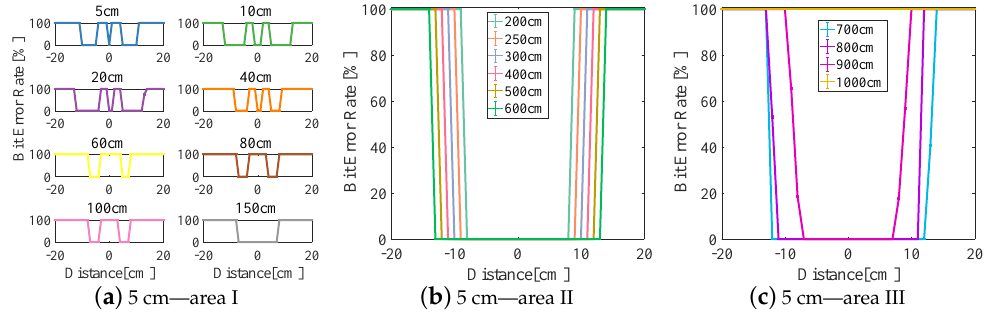
Figure 9. Lampshade height: 5 cm.